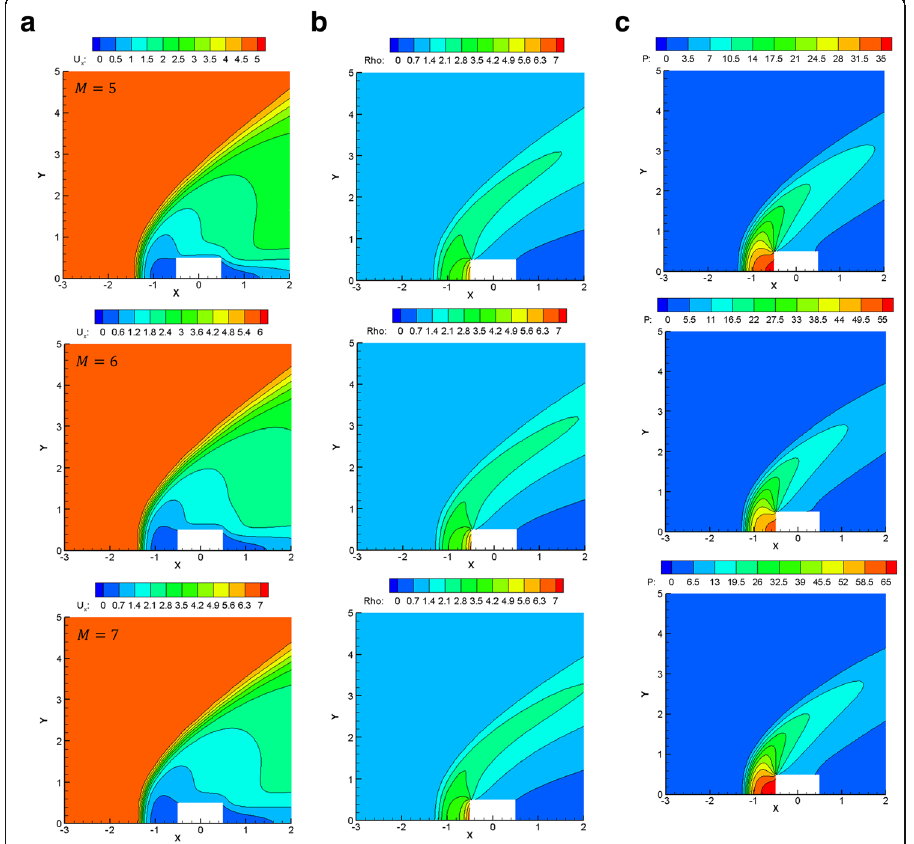
Fig. 6 Contour plots of normalized conserved variables for different Mach numbers (5, 6, and 7), plotted in rows, at Kn = 0.005: a U x velocity, b density, and c